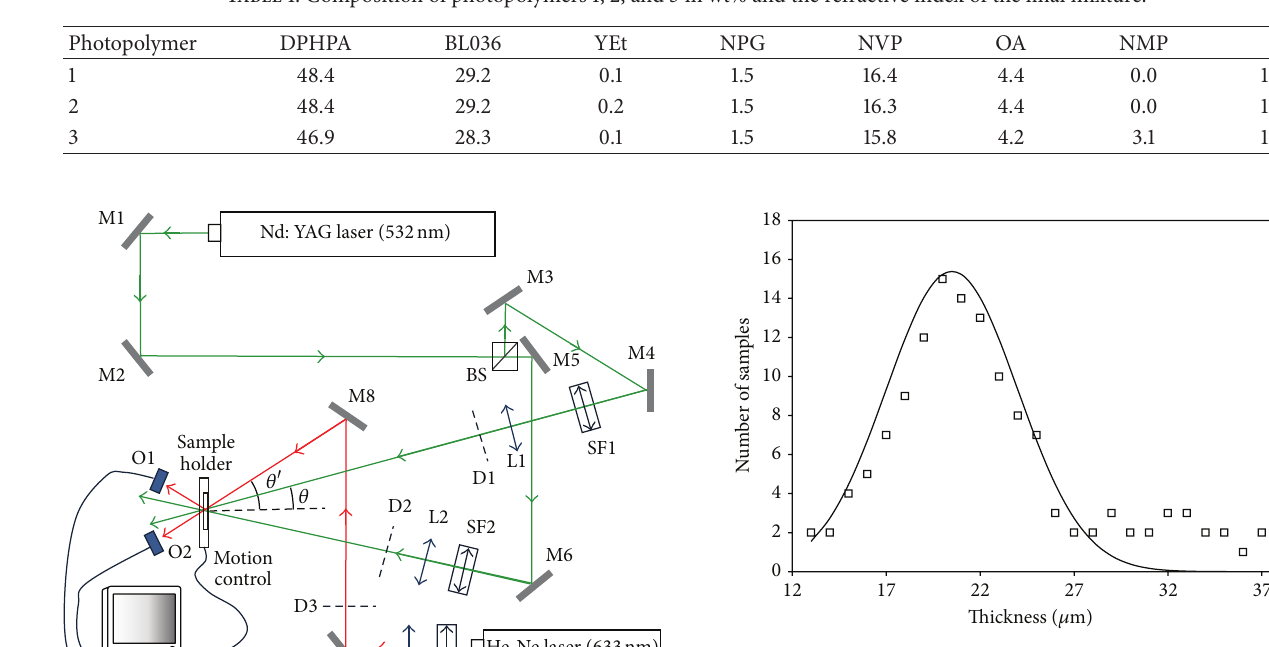
Figure 2: Number of samples as a function of the physical thickness using chemical composition 1 and microspheres 13 𝜇 m in diameter, hollow squares. Gaussian distribution, solid